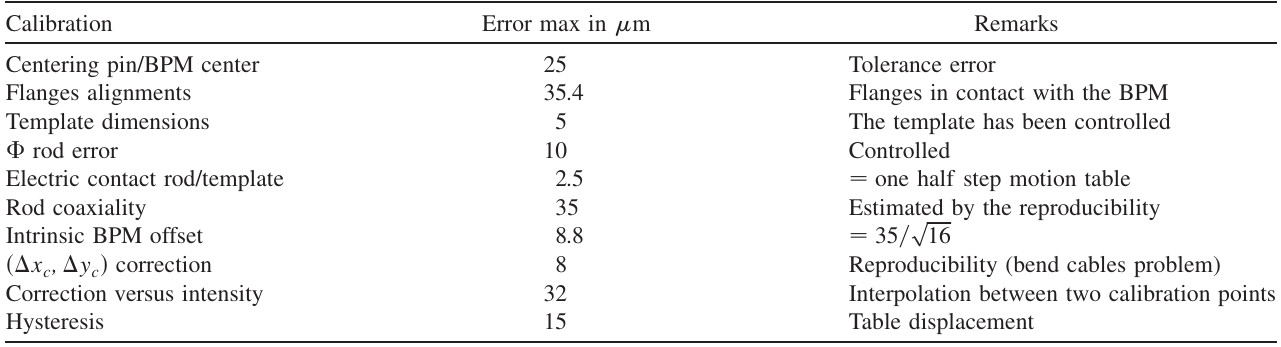
TABLE VI. Test stand and calibration error